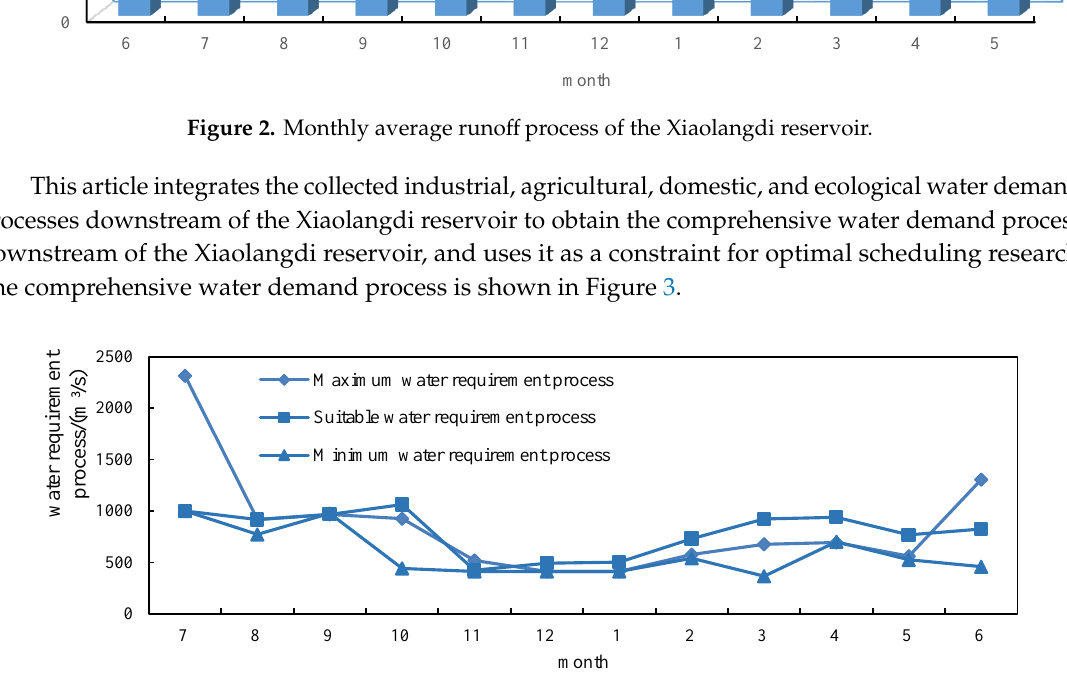
Figure 3. Integrated water requirement process in the lower reaches of Xiaolangdi.